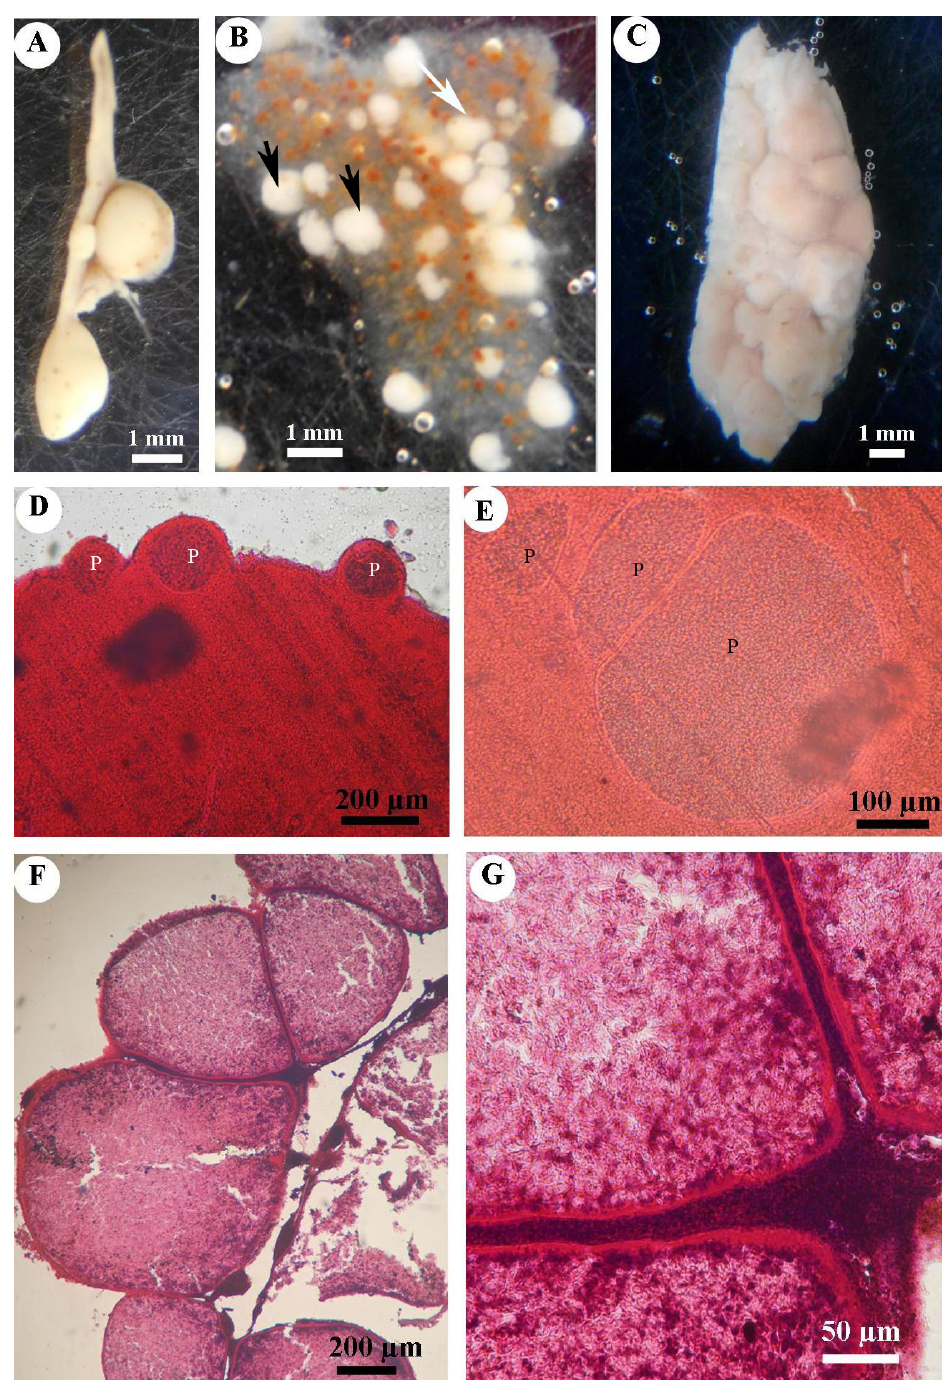
Fig. 3. A–C . Photomicrographs of plasmodia of Myxobolus opsaridiumi sp. nov. affecting a spleen of Opsaridium ubangiensis (Pellegrin, 1901). A . Spleen harbouring large plasmodia. B . Whitish plasmodia isolated from each other (black arrows) or arranged in grape-like clusters (white arrow). C . Spleen completely filled with plasmodia. – D–G . Histological sections stained with hematoxylin and eosin of spleens of O. ubangiensis infected with plasmodia of M. opsaridiumi sp. nov. D . Plasmodia implanted on the external region of the spleen. E . Asynchronous development of plasmodia within the spleen. F . Mechanical compression of the cells adjacent to the cysts. G . Higher magnification of plasmodia showing each surrounded by a wall and full of myxospores. Abbreviation: P =